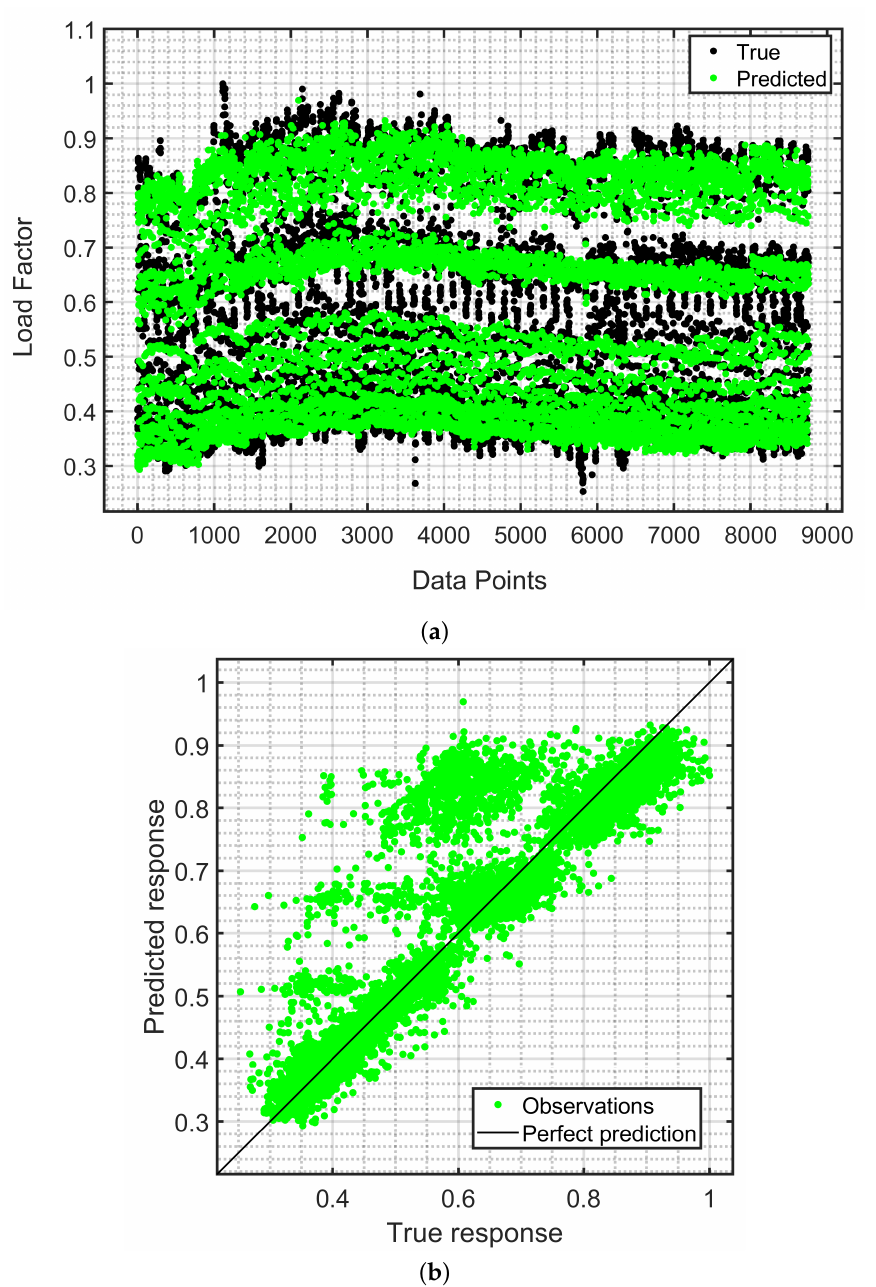
Figure 11. Results with Support Vector Machines. ( a ) Actual versus predicted values of Support Vector Machines. ( b ) Linearity analysis of Support Vector